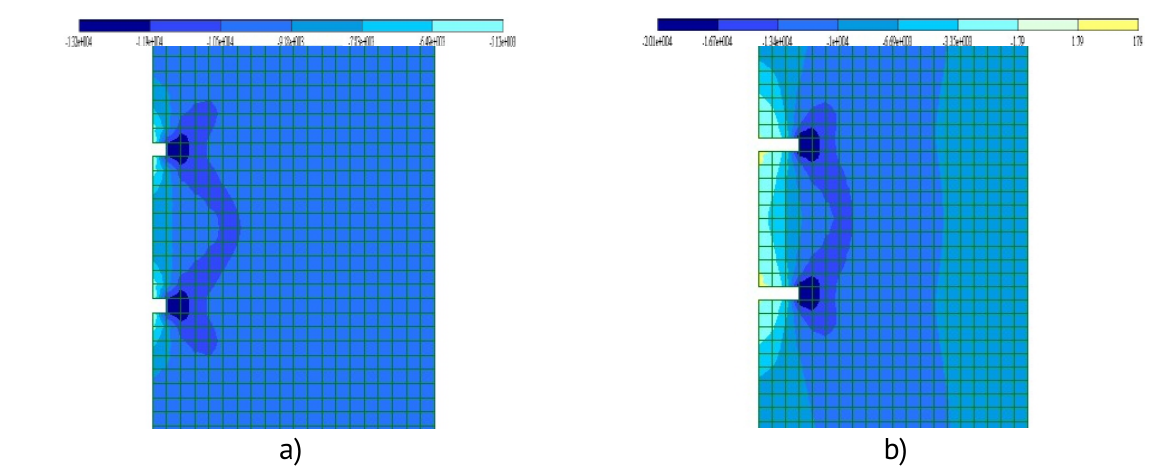
Figure 5. Stress fields Ny in the area with structural defect: defect depth 5 mm (а) and 15 mm (b) for concrete grade С16/20 under stress in concrete